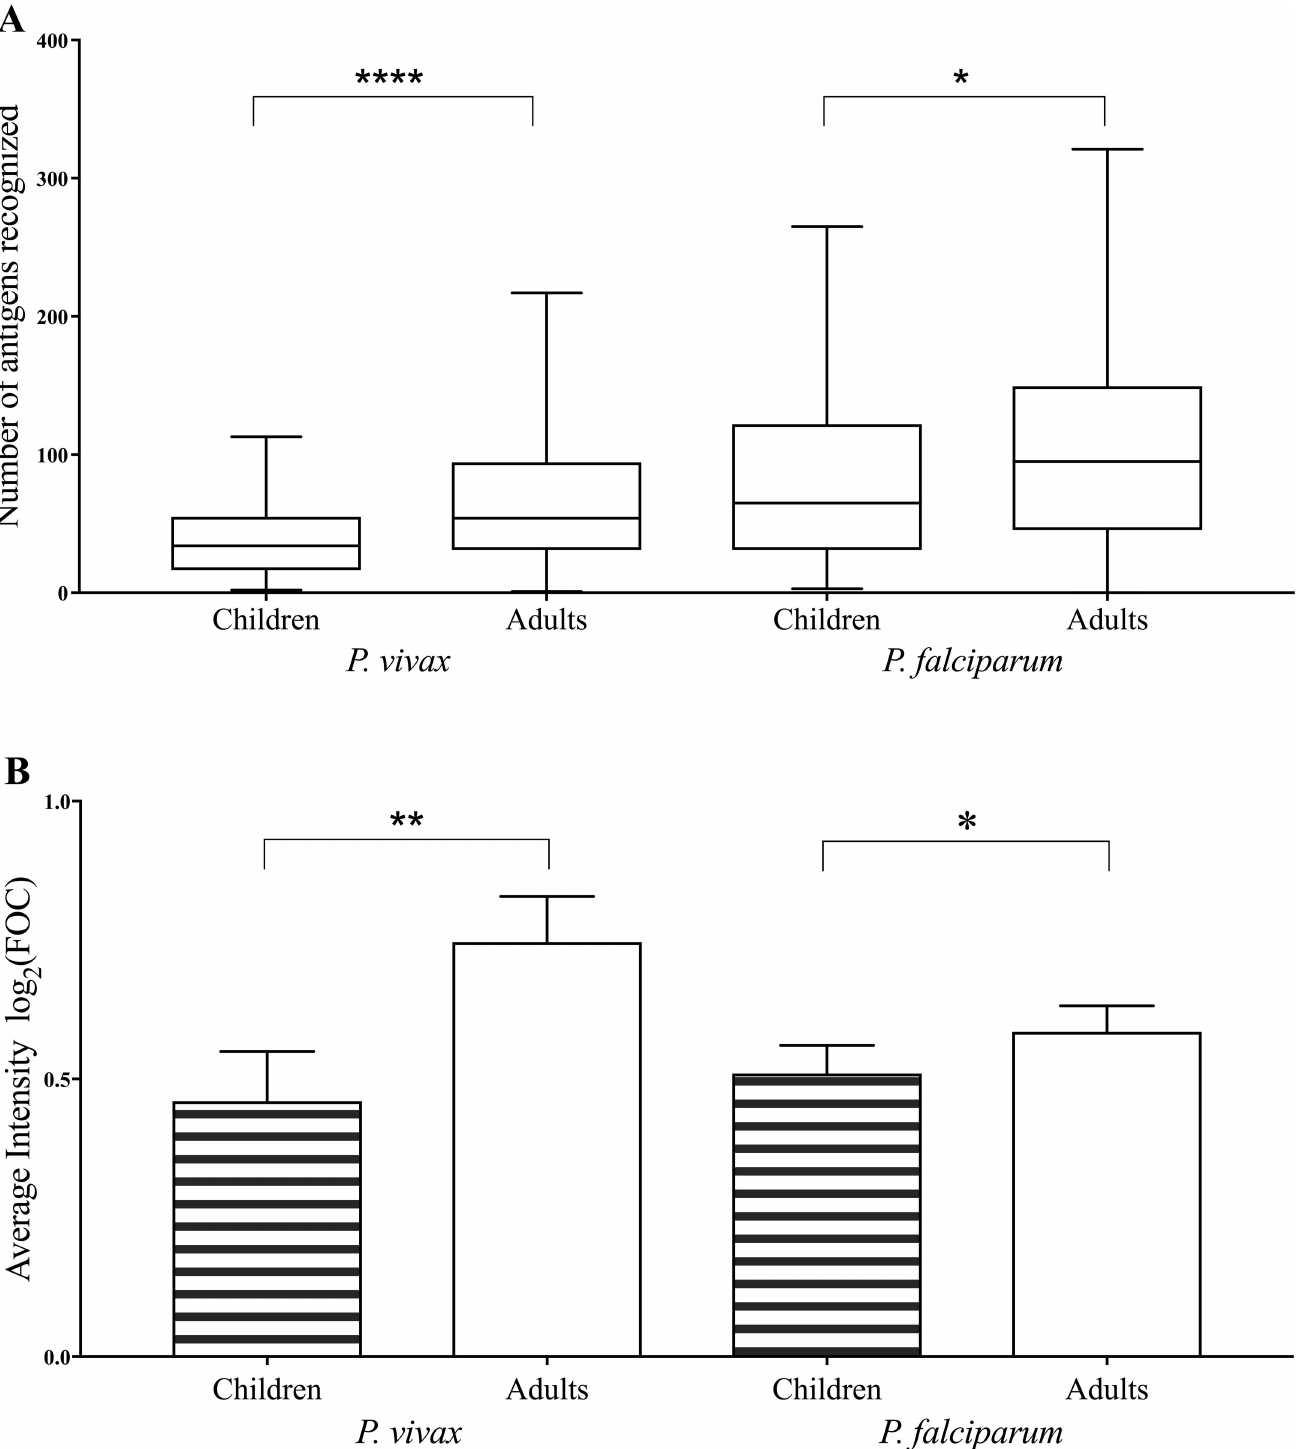
Fig 3. Age-dependent breadth and intensity of response to P . vivax and P . falciparum . Age-dependent A) breadth of responseto 265 P . vivax and 373 P . falciparum antigensin children(n = 61) and adults (n = 129) from Raurkelaand Nadiad. The box indicatesthe first and third quartiles, the line inside the box indicatesthe median,and whiskers represent the minimum and maximum values. B) Average of mean intensity of antibodybindingto the same subset of P . vivax and P . falciparum antigensin childrenand adults, top of bars indicatethe mean value and error bars represent 95% confidence interval of the mean. Kruskal–Wallis/Dunnadjustedp-valuesfor pairwise comparison of groups are shown as asterisks: 0.03 ( * ), 0.002 ( ** ), 0.0002 ( *** ), < 0.0001( **** ).